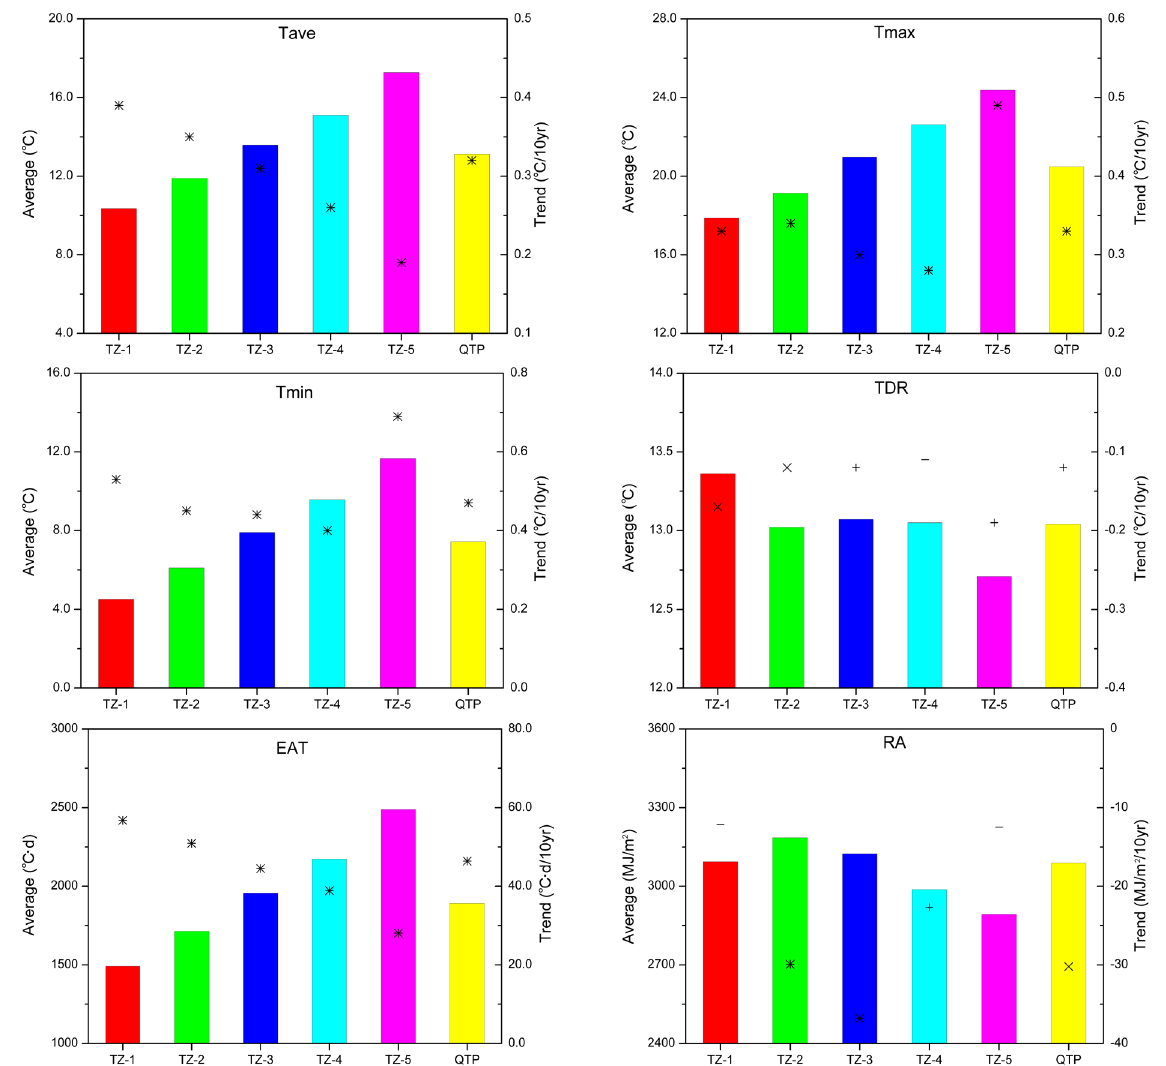
Figure 6. Annual averages (columns) and change trends (scatters) of Tave, Tmax, Tmin, TDR, EAT and RA in the growing season in different zones and the QTP. + , × and * indicate significant at 0.1, 0.05 and 0.01 levels, and − indicates insignificant change,